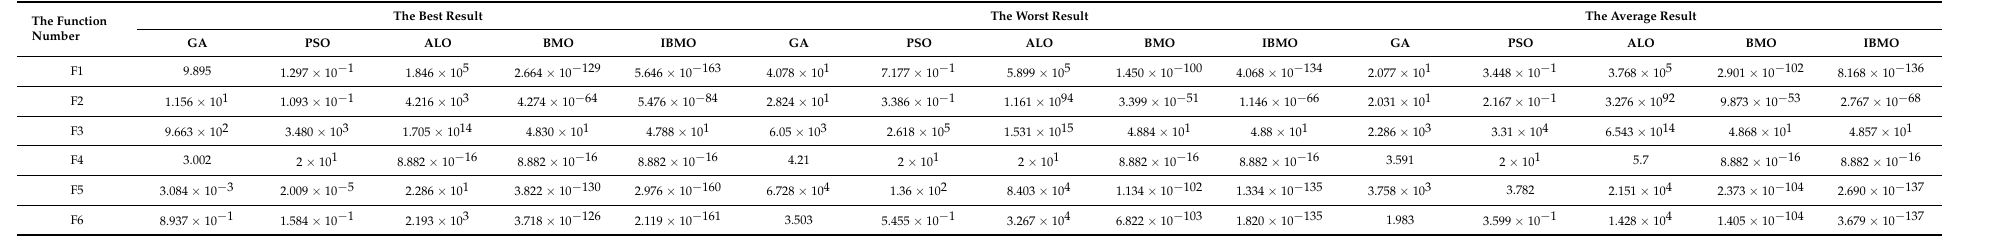
Table 2. Test results of optimization